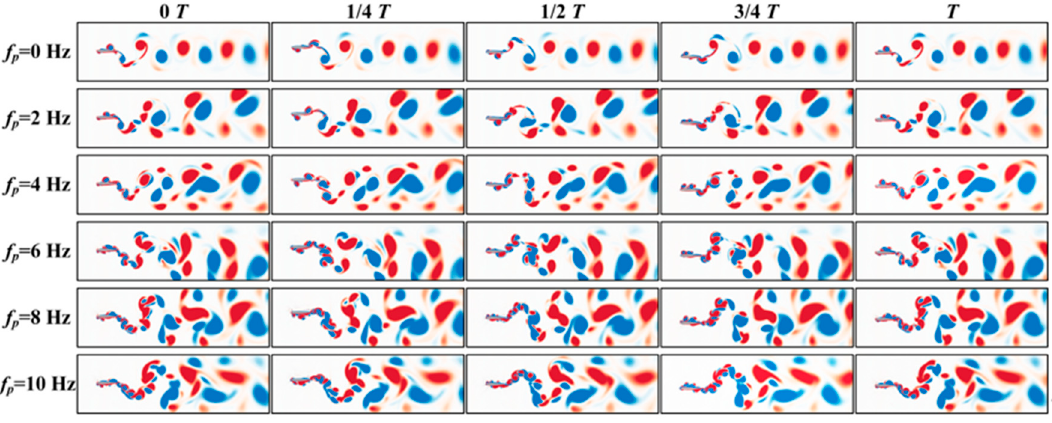
Figure 9. Instantaneous wake structure for foil at k = 2.